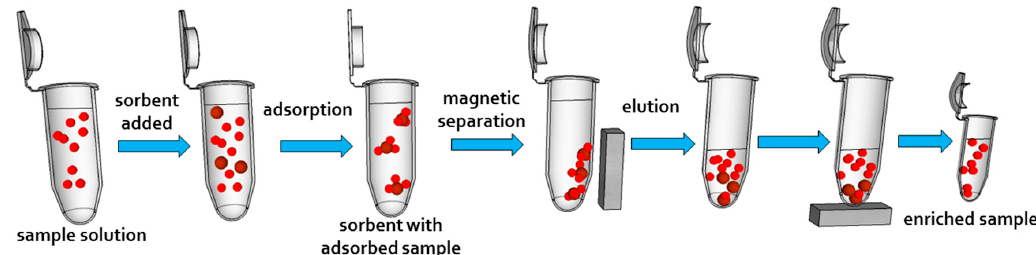
Figure 4. The scheme of an magnetic solid phase extraction procedure. Magnetic sorbent is added